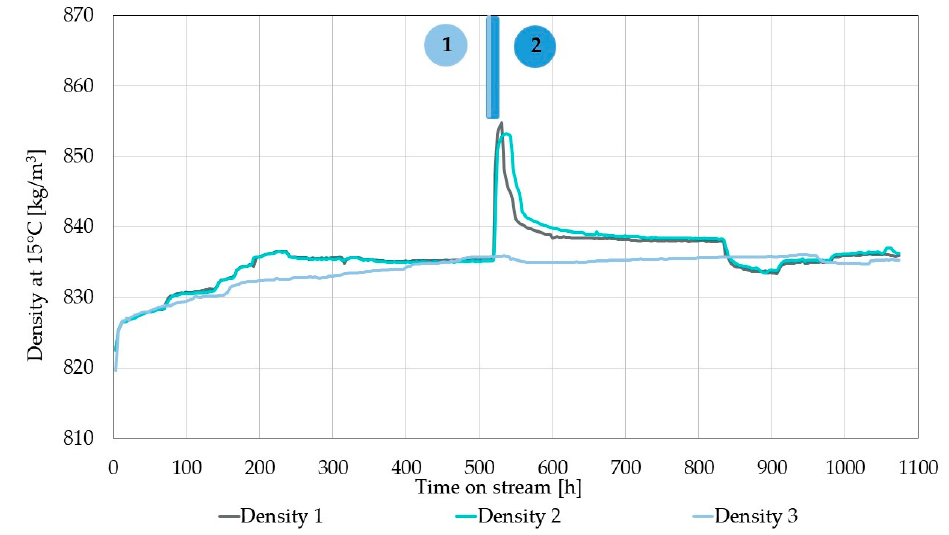
Figure 4. Density during the three